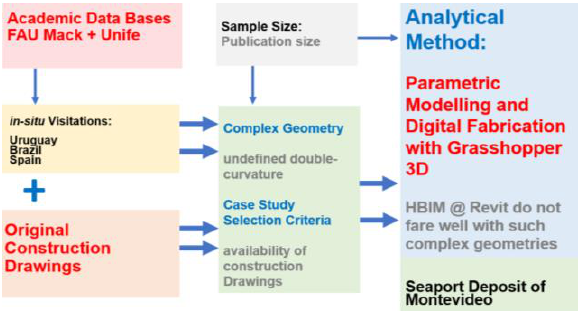
Figure 2: Methodology